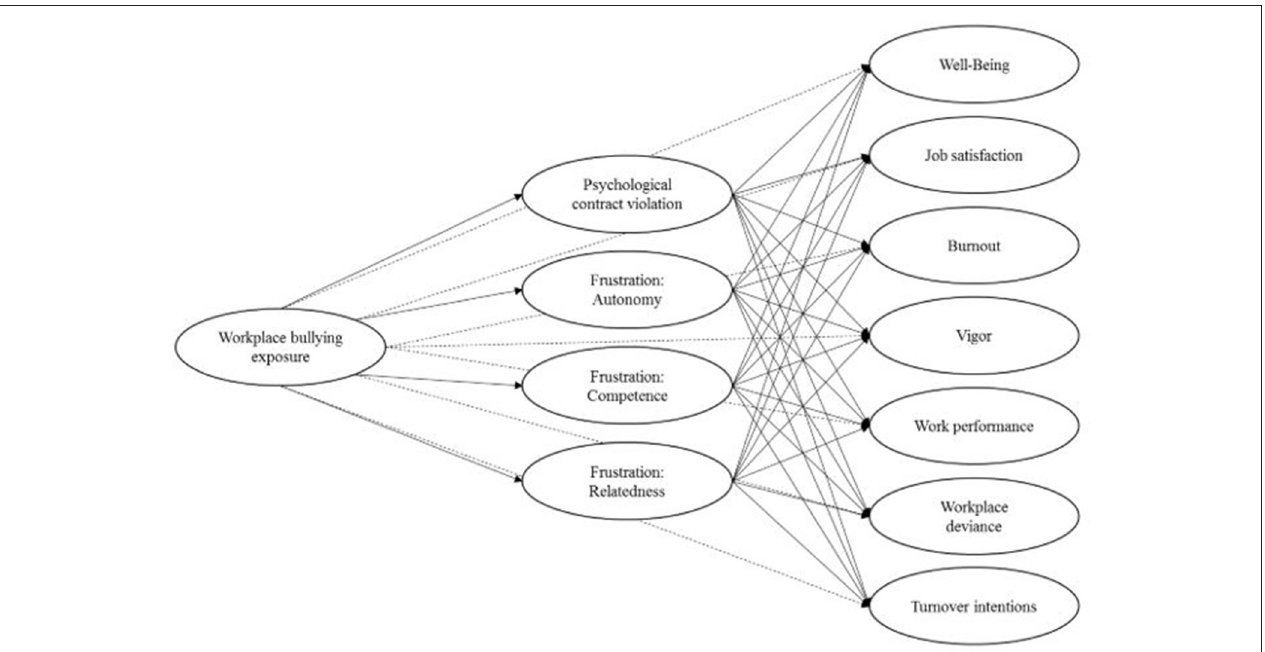
FIGURE 1 | The proposed model. Solid lines, hypothesized associations; dashed lines, controlled